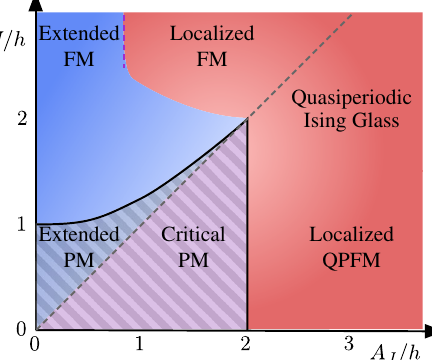
FIG. 1. Combined symmetry breaking and localization phase 0 . The system diagram of the quasiperiodic Ising model at A h ¼ has quasiperiodic Ising glass excited-state order at all energy densities in the red region, where all single-particle excitations are localized. The ground state is paramagnetic (PM) in the striped region; it breaks Ising symmetry ferromagnetically (FM) above the diagonal (dashed line) and with quasiperiodically alternating modulation (QPFM) below. The blue and purple shading indicates whether the low-energy spectrum is fully extended (blue) or critically delocalized